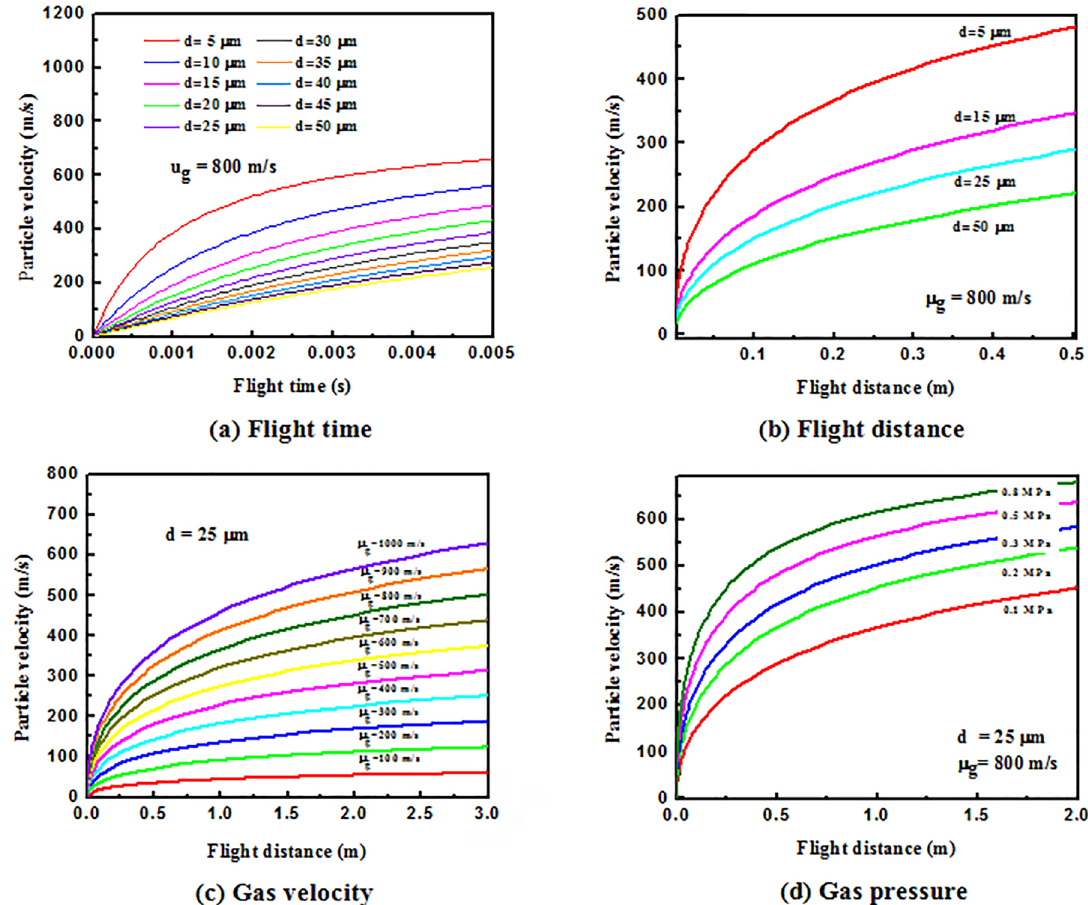
Figure 1. Relationships between the particle velocity and spraying parameters for flight time (a), flight distance (b), gas velocity (c), and gas pressure (d)